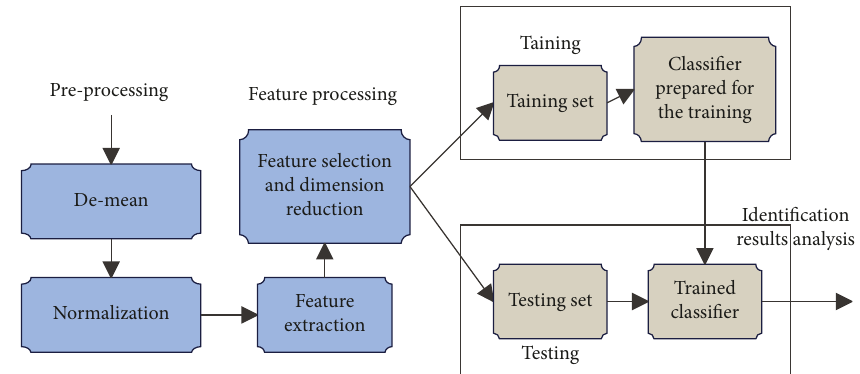
Figure 9: General framework of trombone timbre feature recognition.